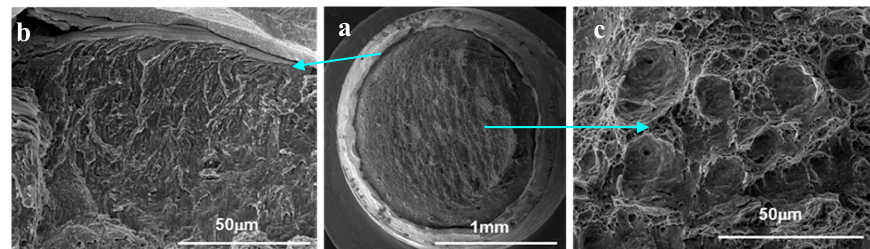
Figure 8. Fracture surface of the notched specimen (B90), originally covered by flux and Pb layer, tested in Ar + 6% H 2 gas at 300 °C and R1 (2 × 10 − 6 m/s); ( a ) general view showing the whole solid lead around the specimen; ( b ) details of the cleavage-like facets of SMIE crack initiating from the notch; and ( c ) ductile dimpled fracture in the center.